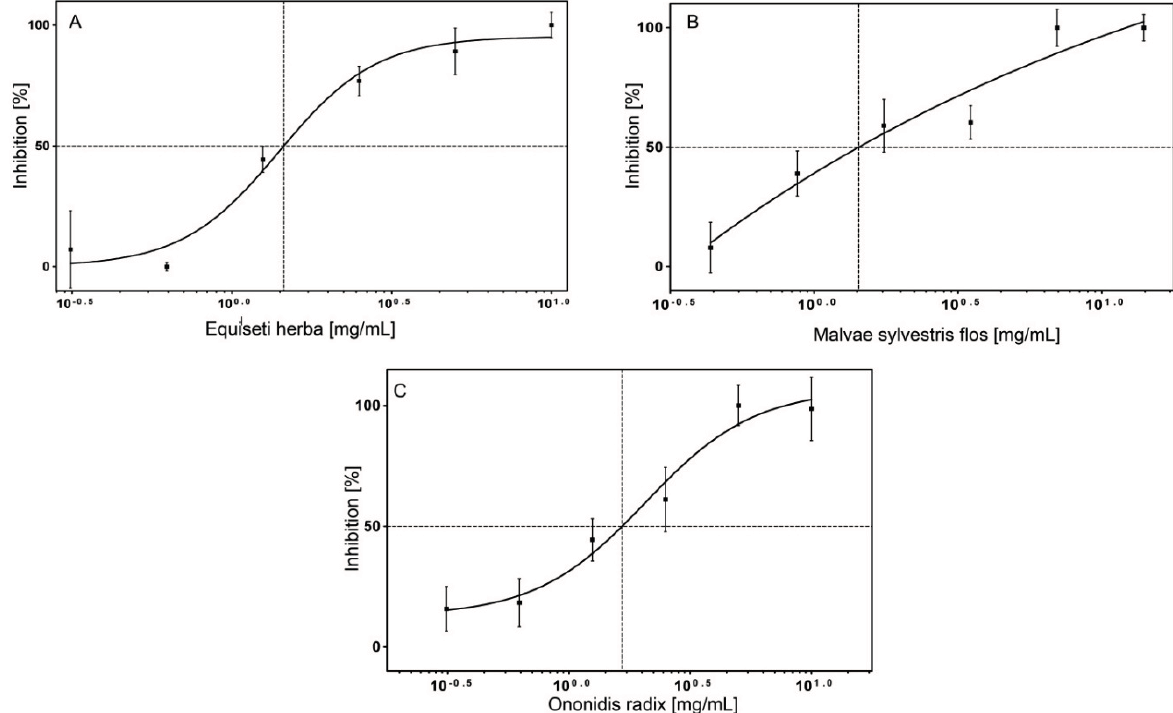
Figure 9. IC 50 values of different plant extracts on surface displayed Hyal-1. ( A ) Equiseti herba ; ( B ) Malvae sylvestris flos ; ( C ) Ononidis radix . Activity of surface displayed Hyal-1